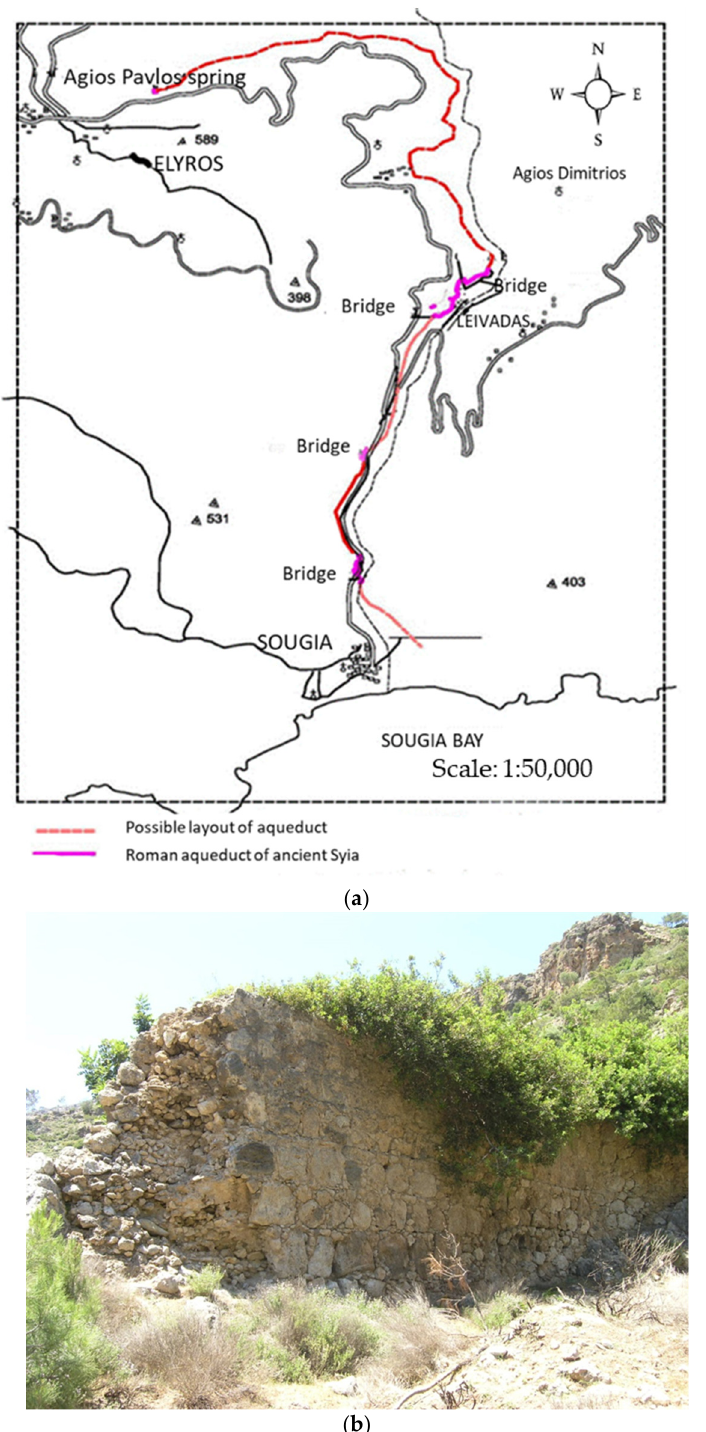
Figure 10. The water pipe route in Syia (Sougia): ( a ) Map on background scale: 1:50,000 (Provided by Y. Christodoulakos on background of the Hellenic Military Geographical Service maps [38]) and ( b ) water channel on wall (photo by Y. Christodoulakos)